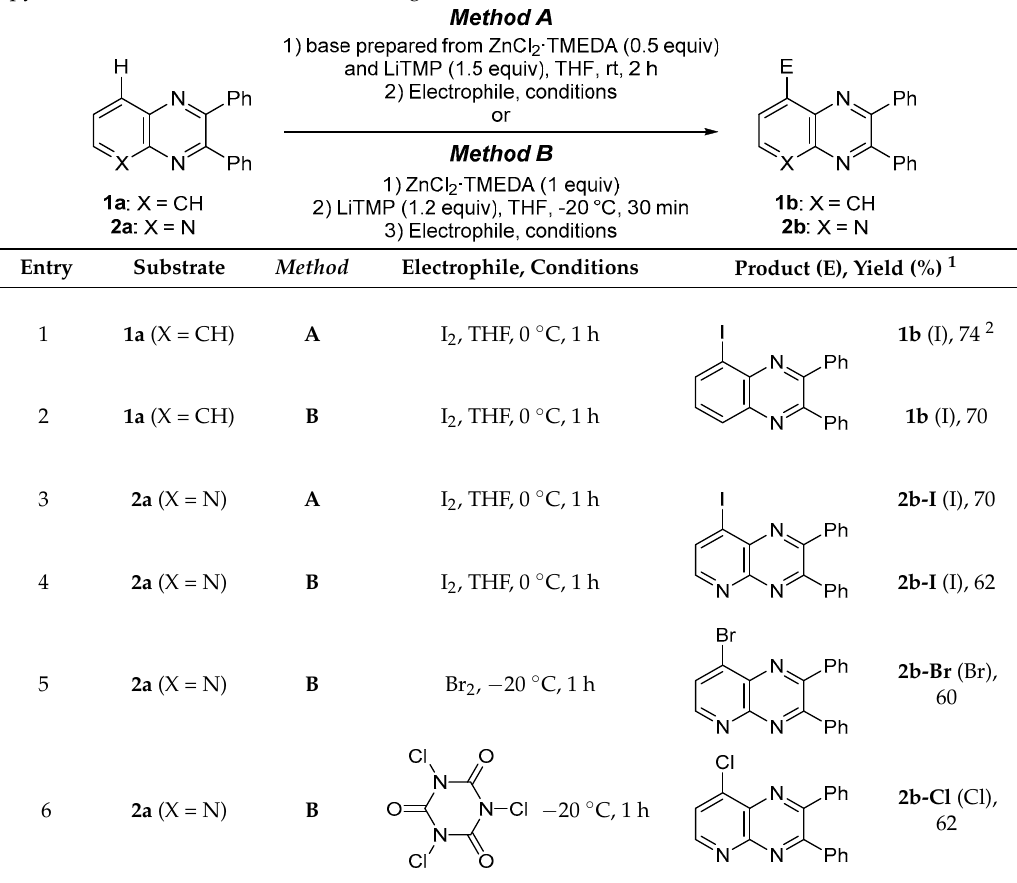
Table 1. Deprotonative metalation of 2,3-diphenylquinoxaline ( 1a ) and 2,3-diphenylpyrido[2,3- b ]-pyrazine ( 2a ) and conversion to the halogeno derivatives.